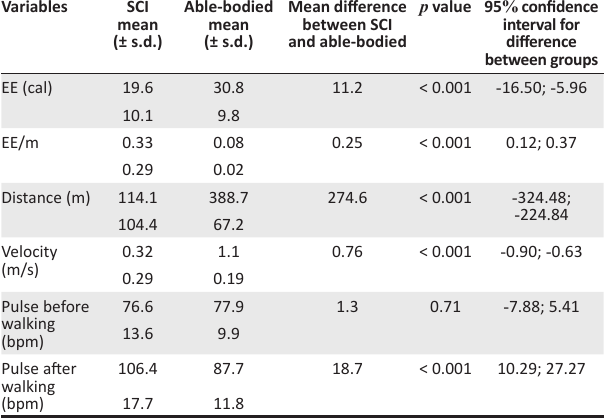
n = 45. SCI, spinal cord injury. TABLE 3: Energy expenditure.